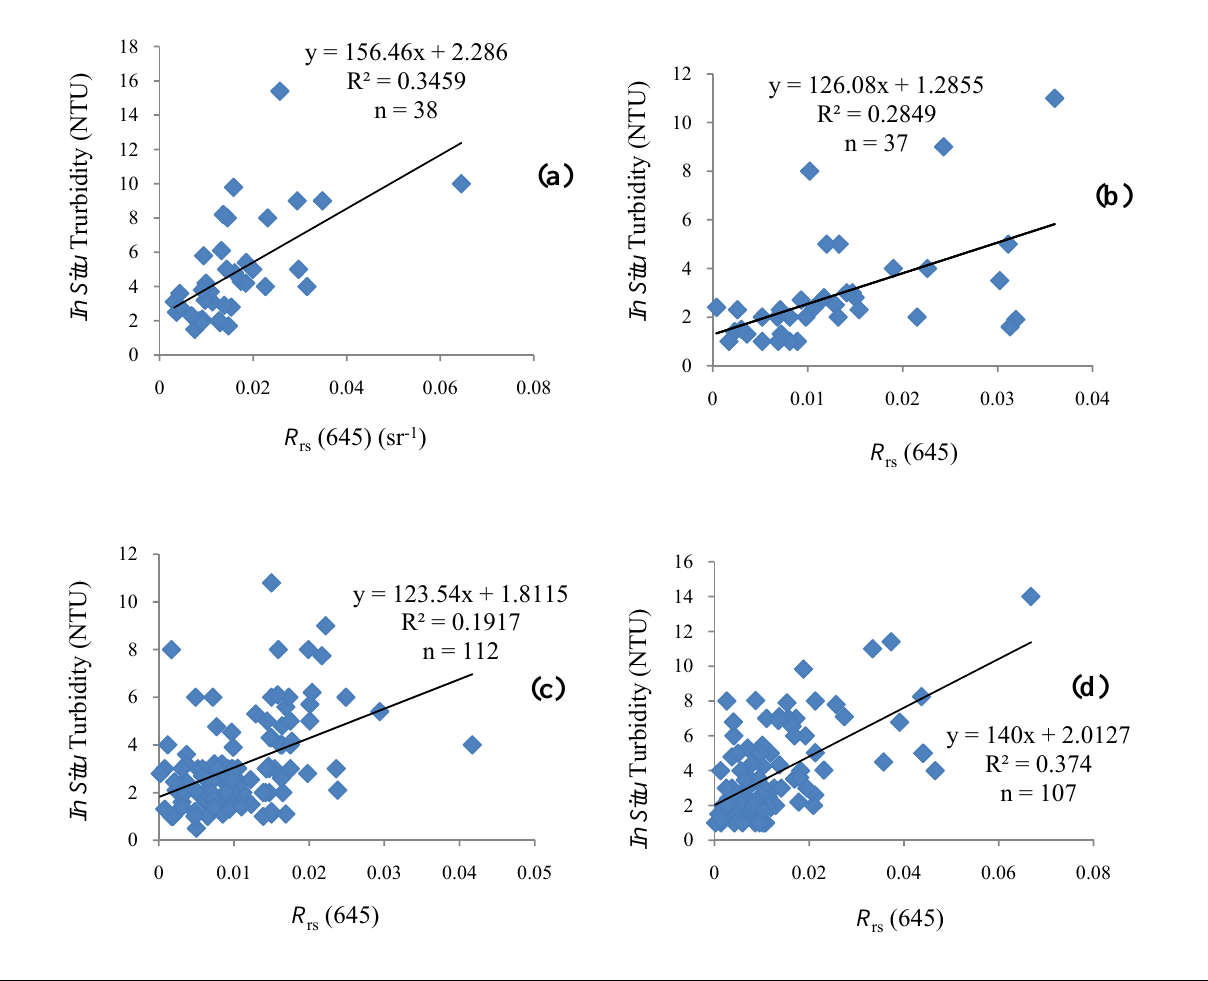
from MOD09GQ by bay rs